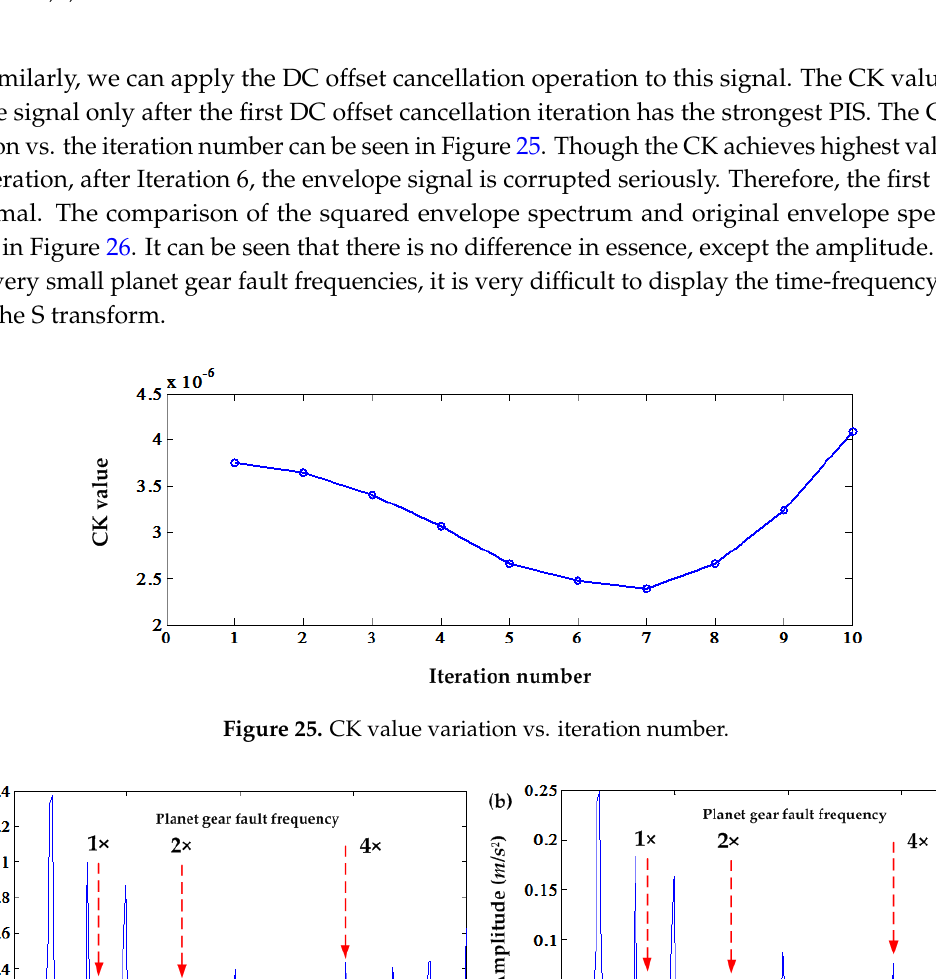
Table 5. Characteristic frequencies (Hz).